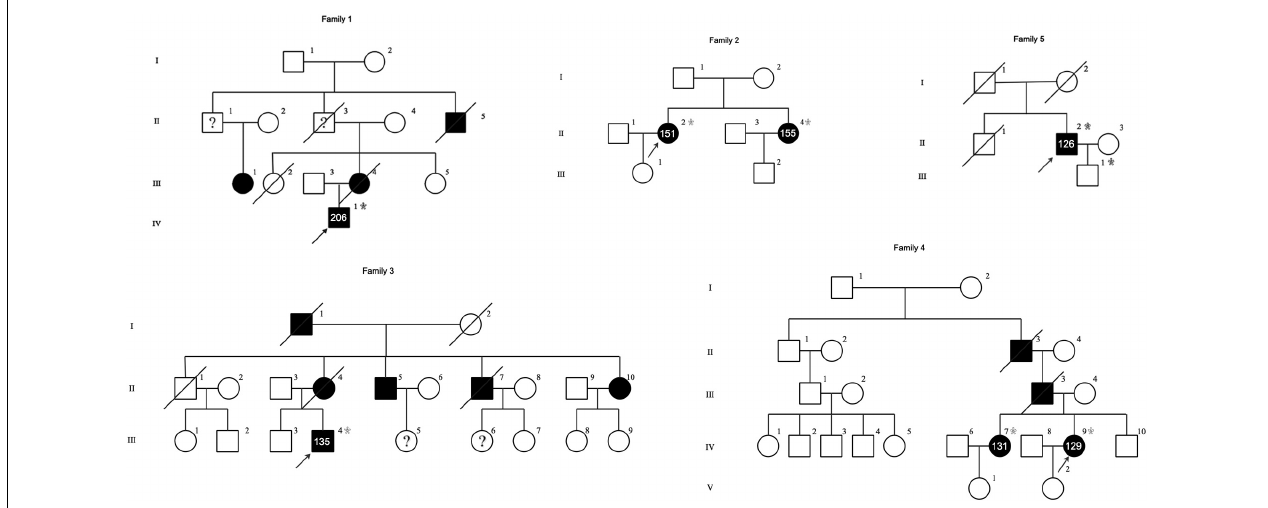
FIGURE 2 | Pedigrees of five unrelated families with the neuropathy phenotype. The squares represent males and the circles represent females. Unaffected and affected individuals are marked by white and black symbols, respectively. The arrow indicates the index. A diagonal line through a symbol indicates a deceased individual. Asterisks indicate patients with available genomic DNA obtained from peripheral blood leukocytes and the number of GGC repeats is indicated. A question mark indicates the patient has suspicious clinical symptoms but without details.